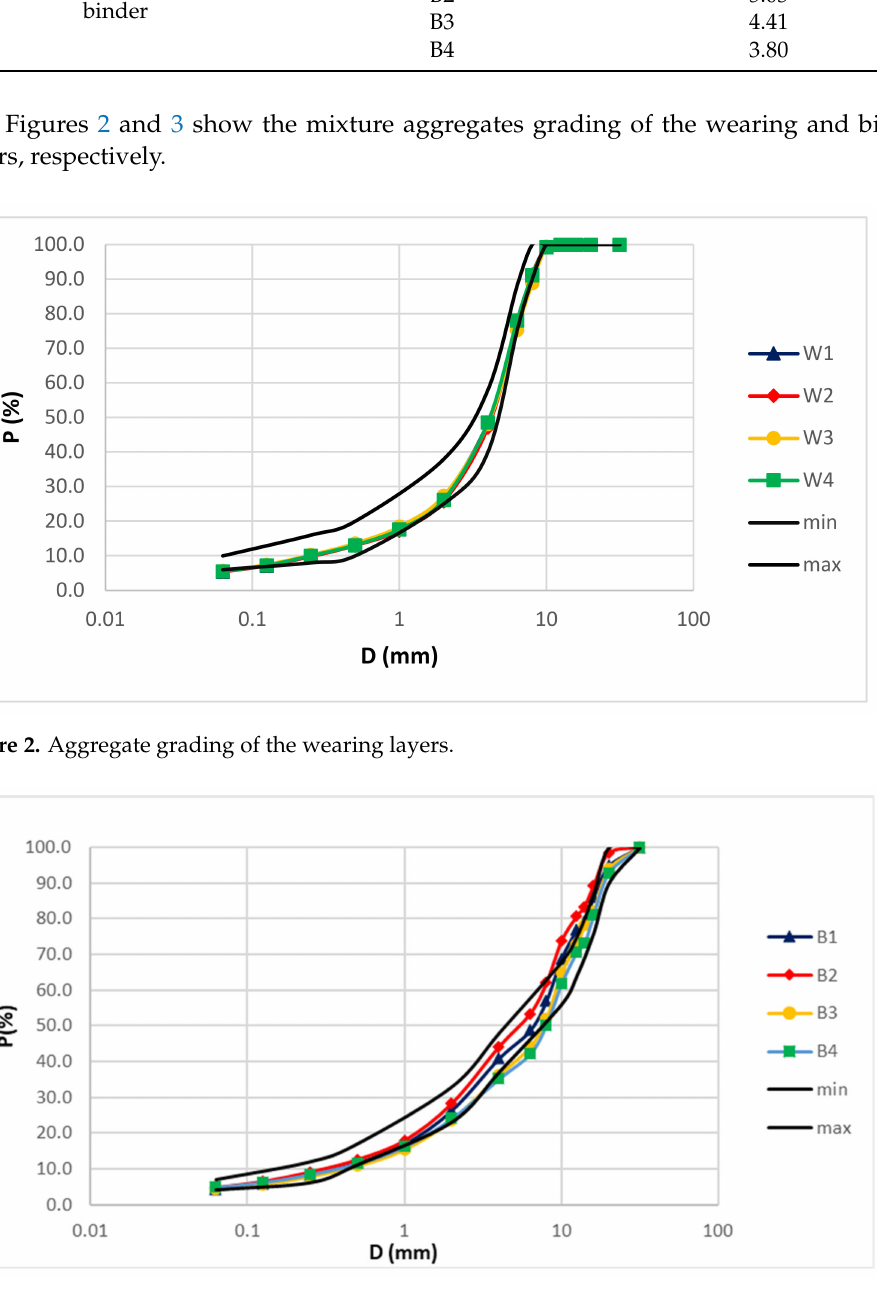
Figure 3. Aggregate grading of the binder